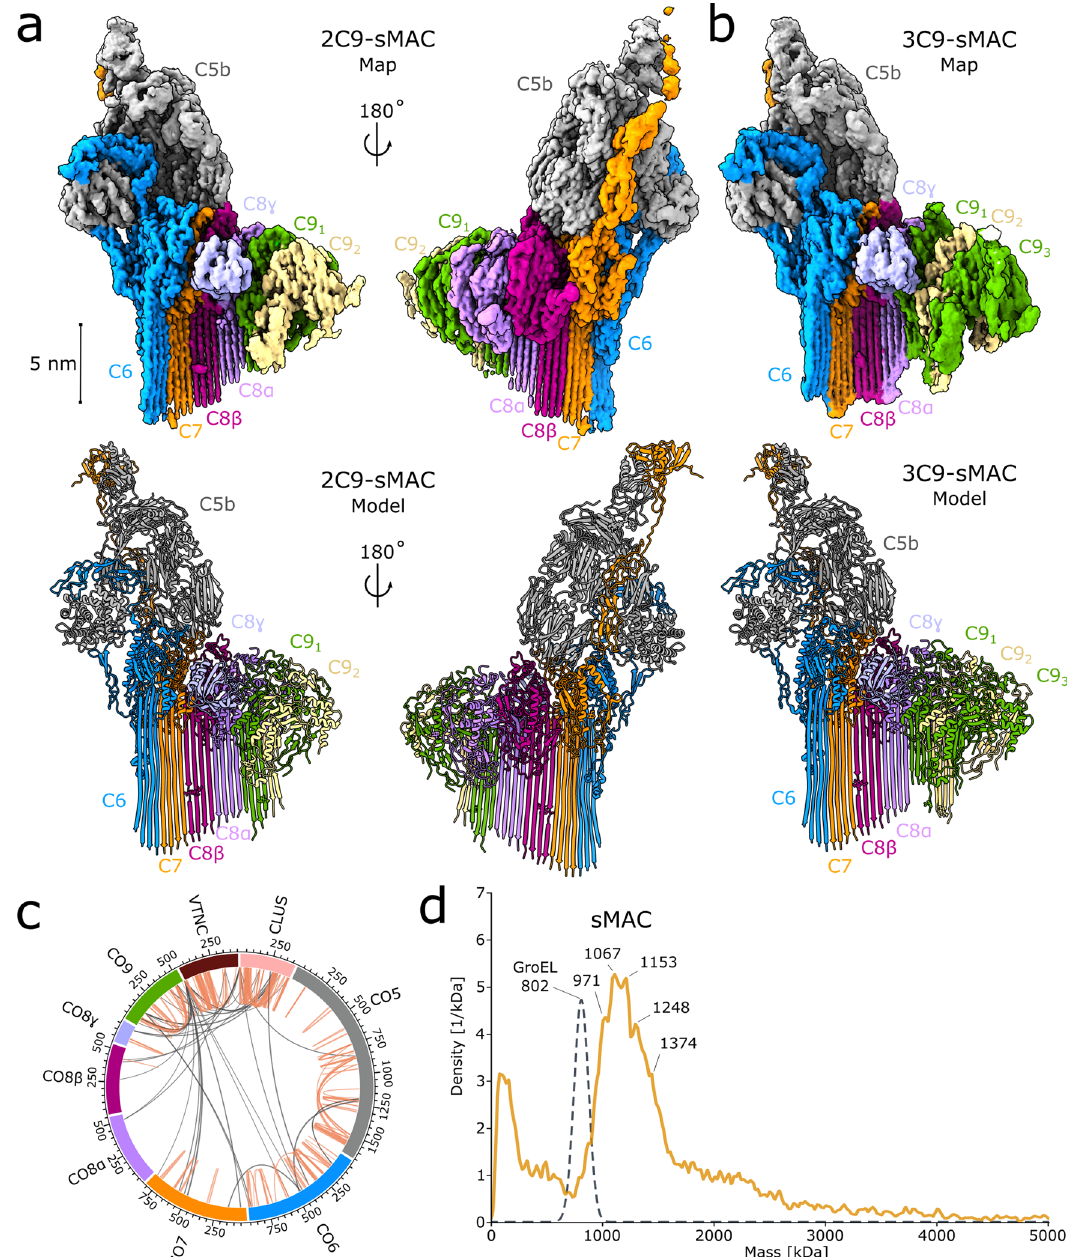
Fig. 1 sMAC is a complement activation macromolecule with a heterogeneous composition. a CryoEM reconstruction (top) and atomic model (bottom) of sMAC that consists of a core complement complex (C5b, C6, C7, and C8 α /C8 β /C8 γ ) together with two C9 molecules (C9 1 , C9 2 ). b CryoEM reconstruction (top) and atomic model (bottom) of sMAC with the same core complement complex and three molecules of C9 (C9 1 , C9 2 , C9 3 ). CryoEM density maps in a and b are colored according to protein composition. Glycans included in the atomic models are shown as sticks in the ribbon diagrams. c sMAC circos plot of identi fi ed 4-(4,6-Dimethoxy-1,3,5-triazin-2-yl)-4-methylmorpholinium chloride (DMTMM) cross-links within and across complement components (C5, C6, C7, C8, and C9). The complement components are cross-linked to the chaperones vitronectin (VTNC) and clusterin (CLUS). Intra-links are shown as orange lines and inter-links are shown as gray lines. Source data are provided as a Source Data fi le. d Mass photometry of sMAC reveals a heterogeneous mixture of complexes (orange line). Masses of the most abundant complexes are indicated. Gaussian distribution of GroEL from the protein standard is shown as a reference for peak width of a homogeneous complex (gray dotted